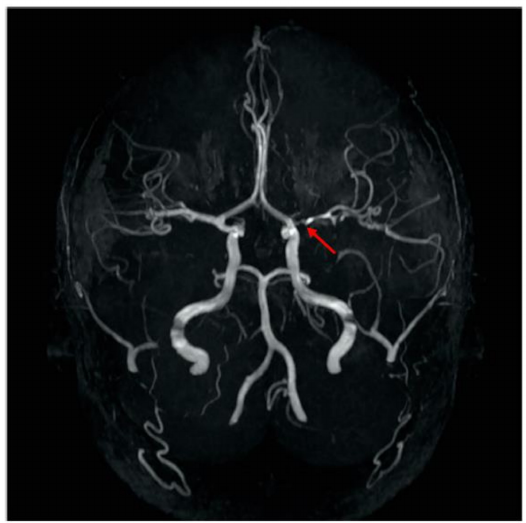
Figure 3. MRA follow up shows narrowing of the left M1 artery four months after roller coaster